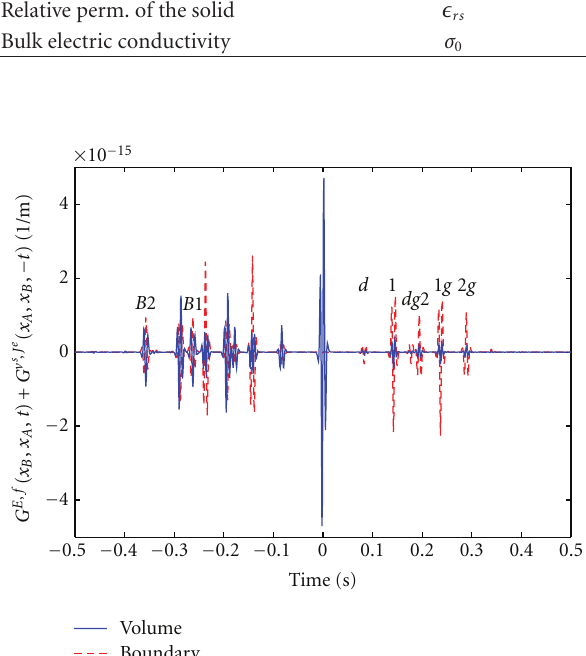
Figure 14: Separated contributions of the domain integral and the boundary points to the retrieved Green’s functions. In other words, it shows the relative contributions of the two right-hand side terms in (50) to the retrieved Green’s functions, for a three-layered medium bounded by a